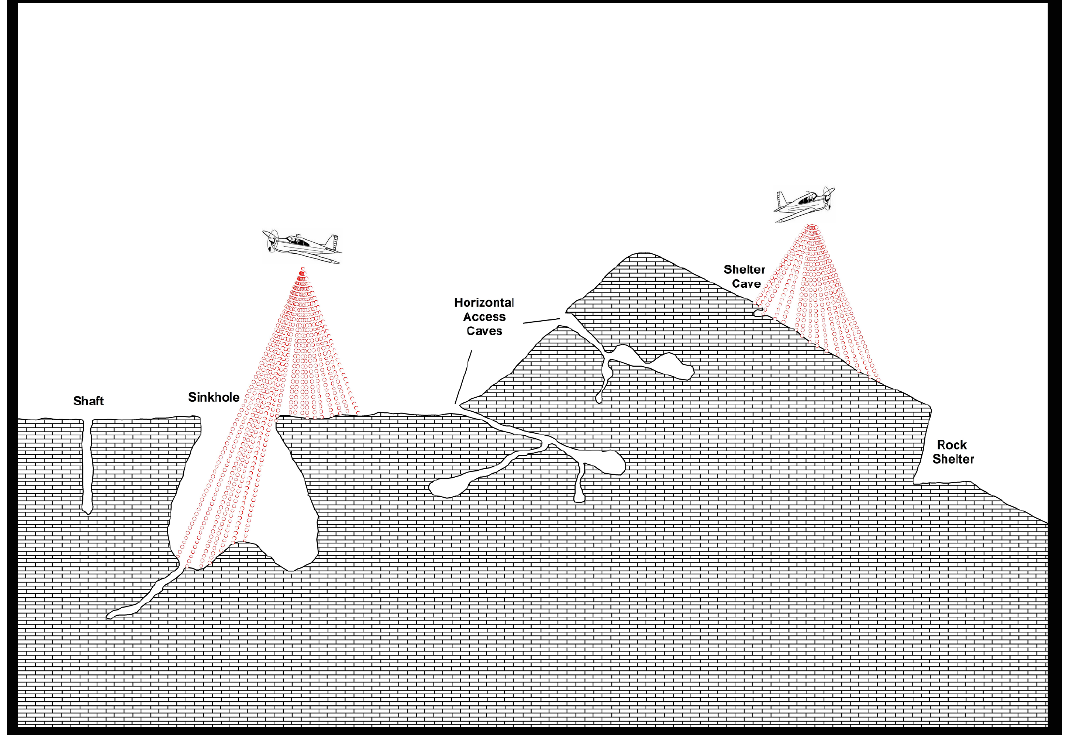
Figure 7. Schematic of lidar pulse angles (image by Shane Montgomery).